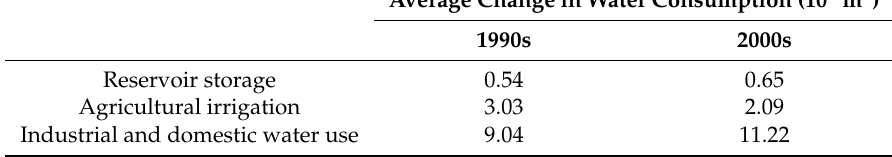
Table 12. Average change in water consumption from the baseline period caused by direct human activities.